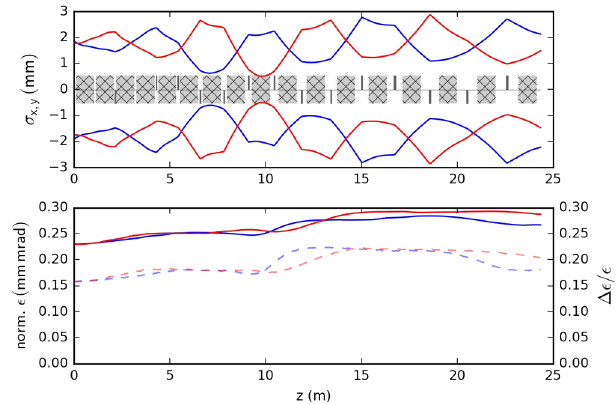
FIG. 12. rms beam envelope through the first arc with waterbag initial distribution and 20 mA bunch current. The circle patterned boxes represent the bending